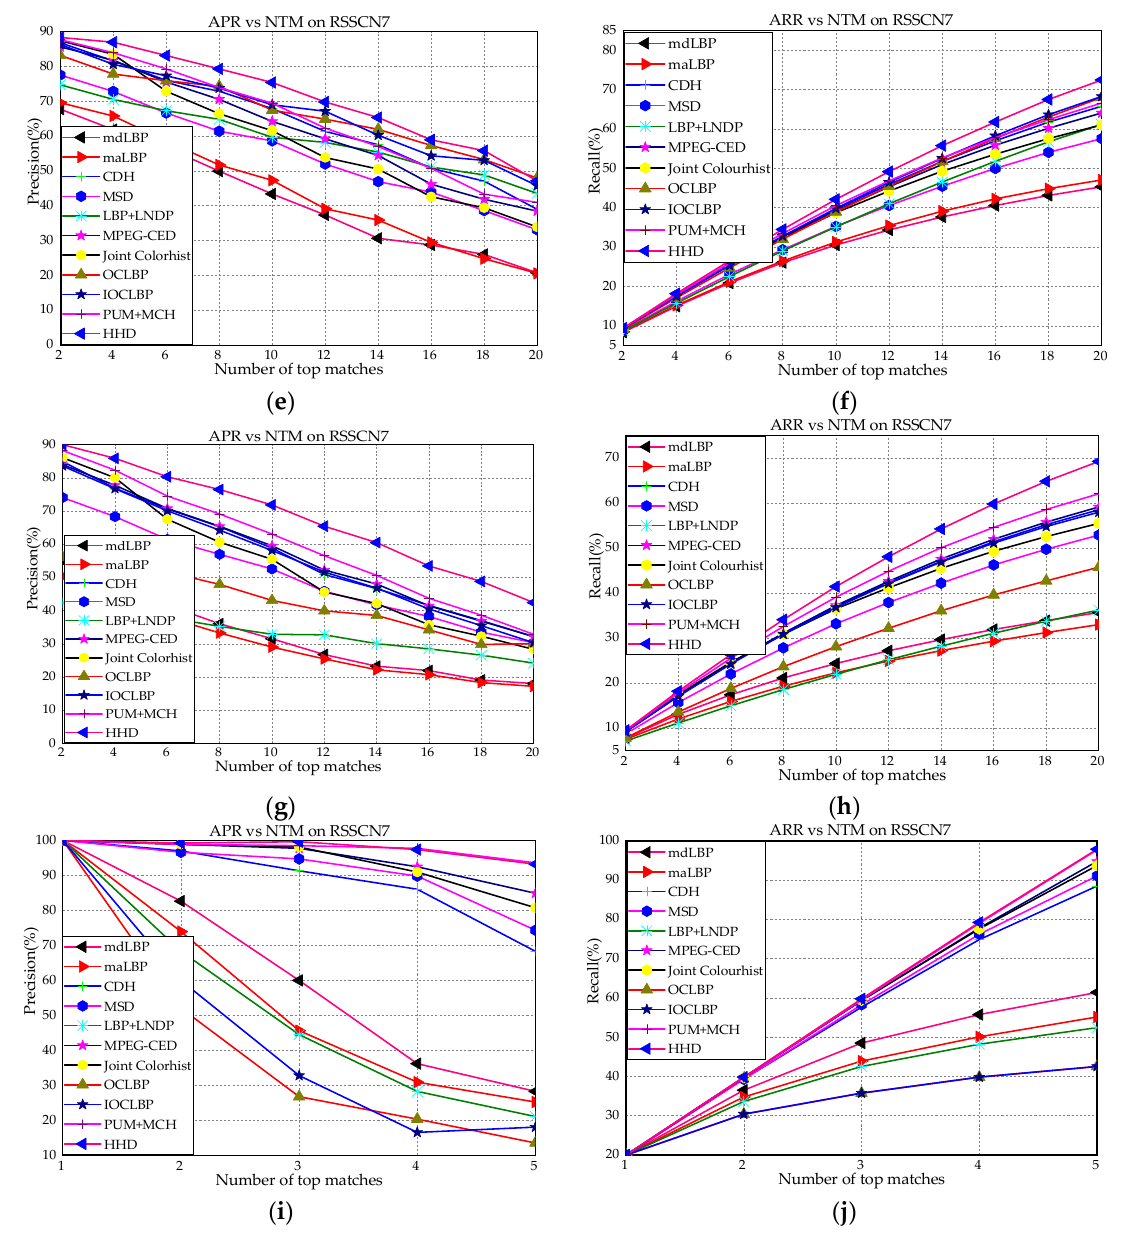
Figure 6. Precision vs. number of top matches (APR vs. NTM) and Recall vs. number of top matches (APR vs. NTM) using different methods over: ( a , b ) RSSCN7; ( c , d ) AID; ( e , f ) Outex-00013; ( g , h ) Outex-00014; and ( i , j ) ETHZ-53.